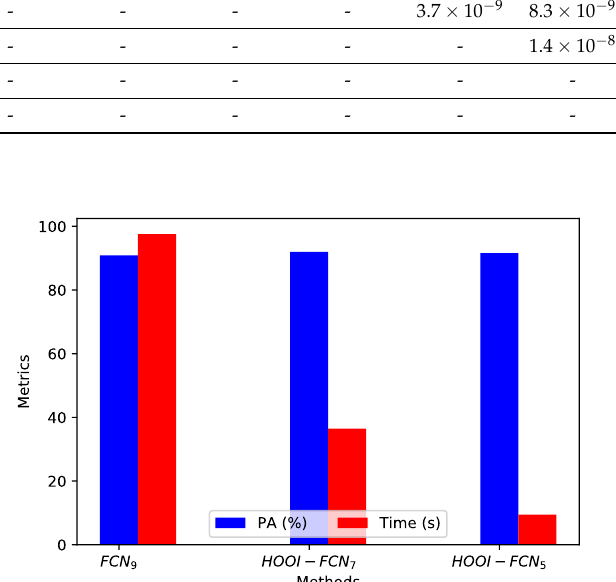
Figure 8. Comparison of the PA and the computational time of FCN with the proposed HOOI-FCN (seven and five bands) for semantic segmentation. See Table